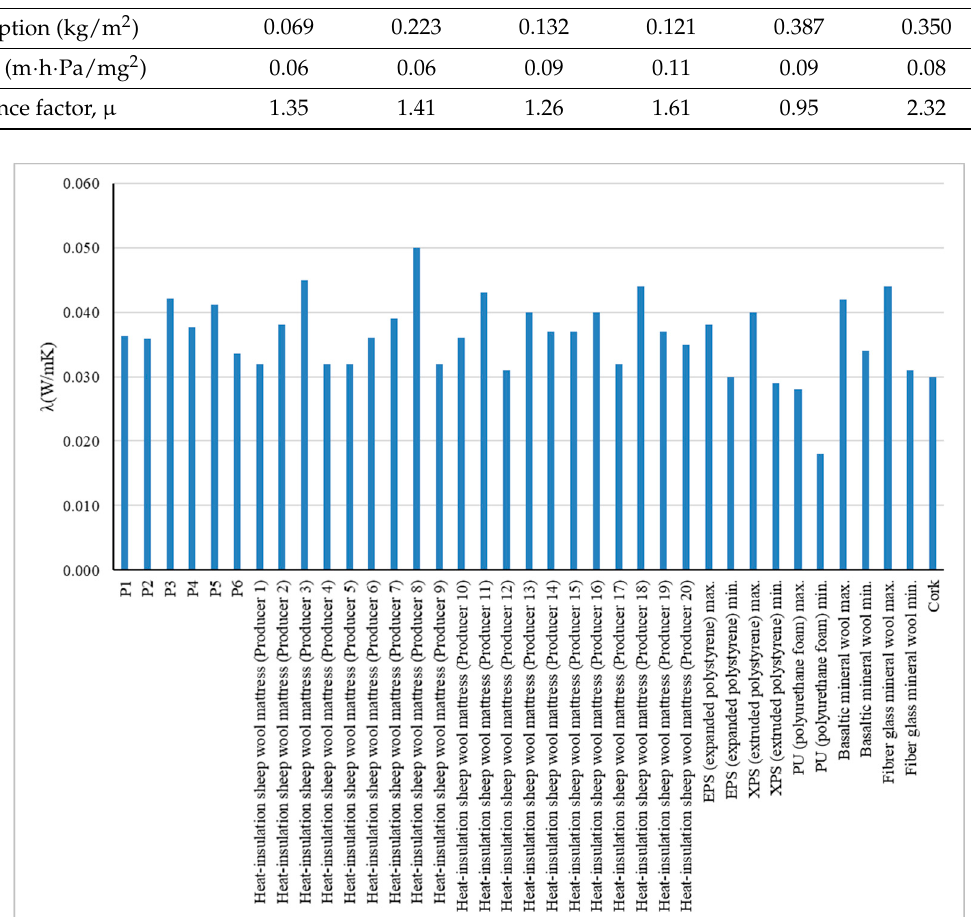
Figure 2. Thermal conductivity coefficient recorded for samples P1–P6 in comparison with the